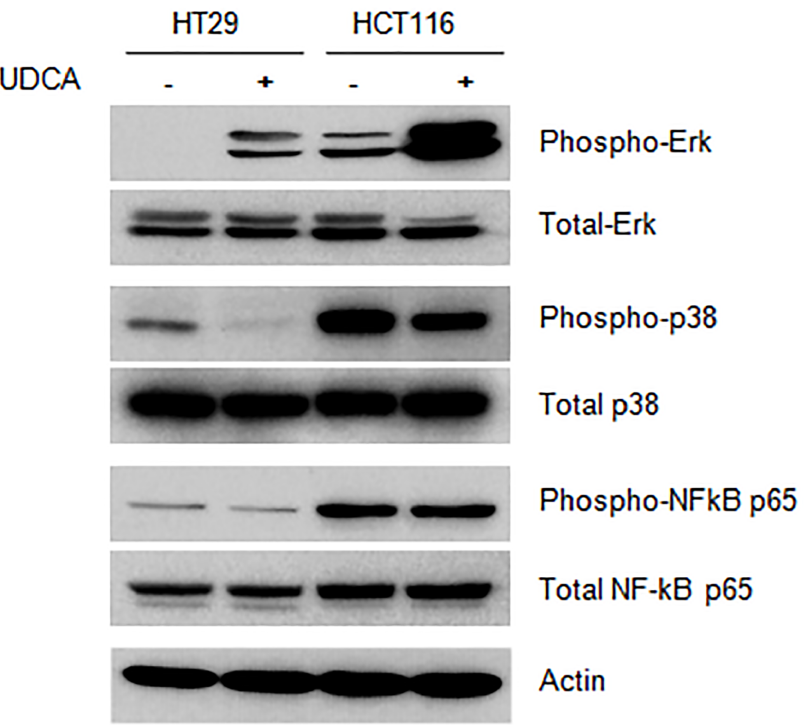
Fig 4. UDCA regulated activation of Erk and p38 pathways. HT29 and HCT116cells were treated with 0.2 mM UDCA for 30 min. The data are representative of experiments performed in triplicate.